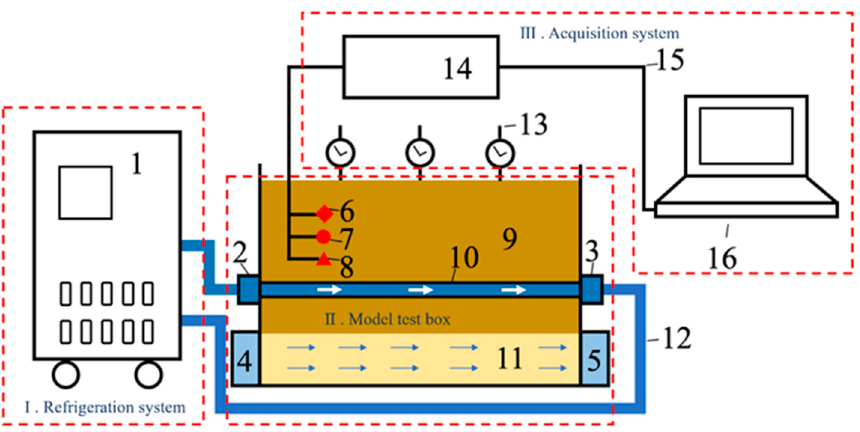
Figure 2. The schematic diagram of the whole experimental system. (1. Refrigerated